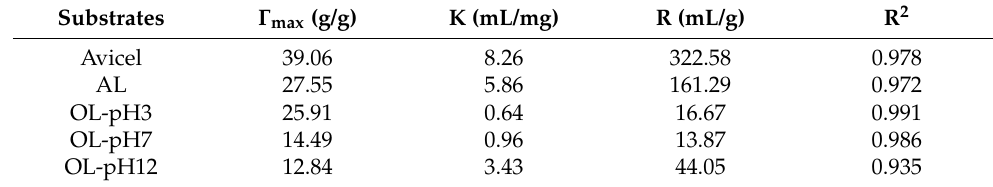
Table 6. Langmuir adsorption isotherm parameters of enzyme adsorption on alkali lignin.